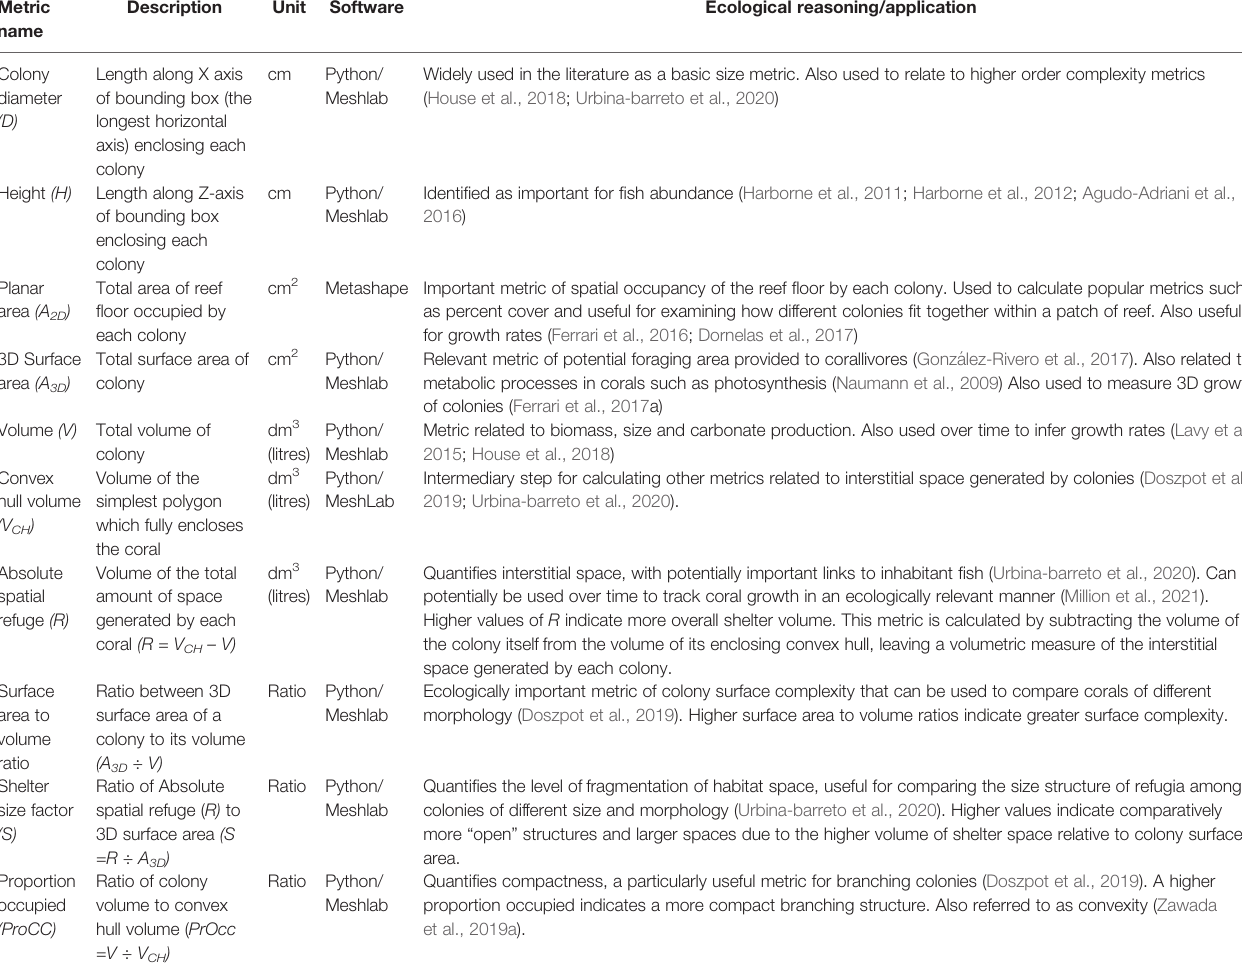
TABLE 2 | Summary of metrics calculated for each colony using a combination of Metashape and